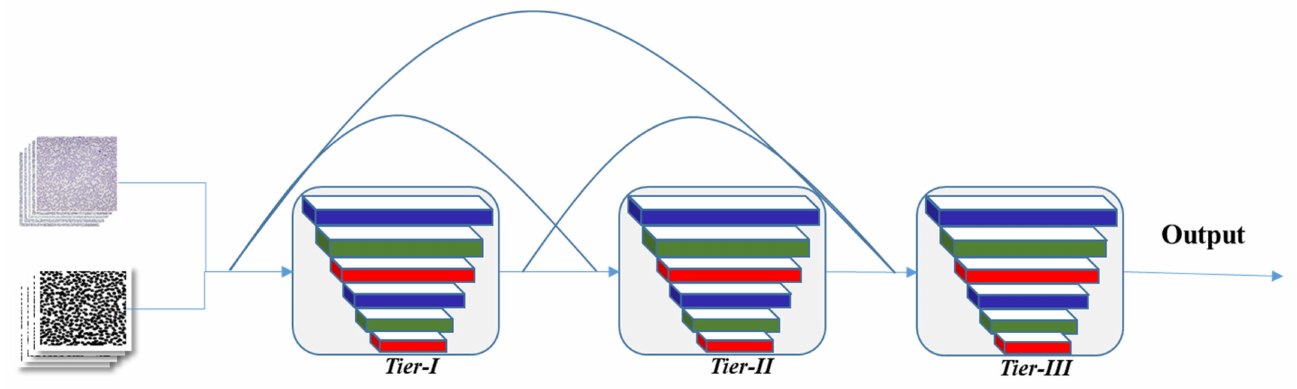
Figure 8. Shows the dense-connection among the tiers of the network. Here covered lines represent the feature map of each tier. These connections illustrate that the feature maps of all preceding networks are used as input to each subsequent